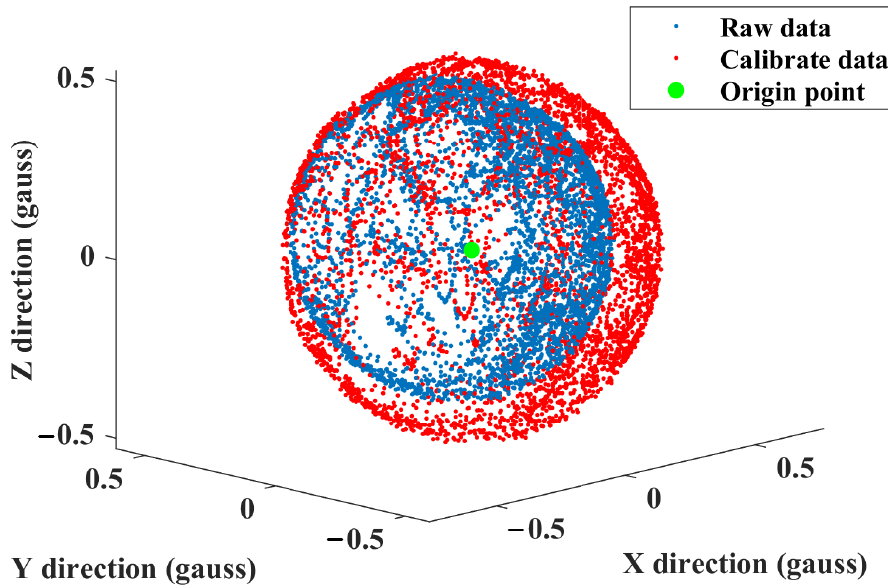
Figure 4. Ellipsoid fitting effect of magnetometer.